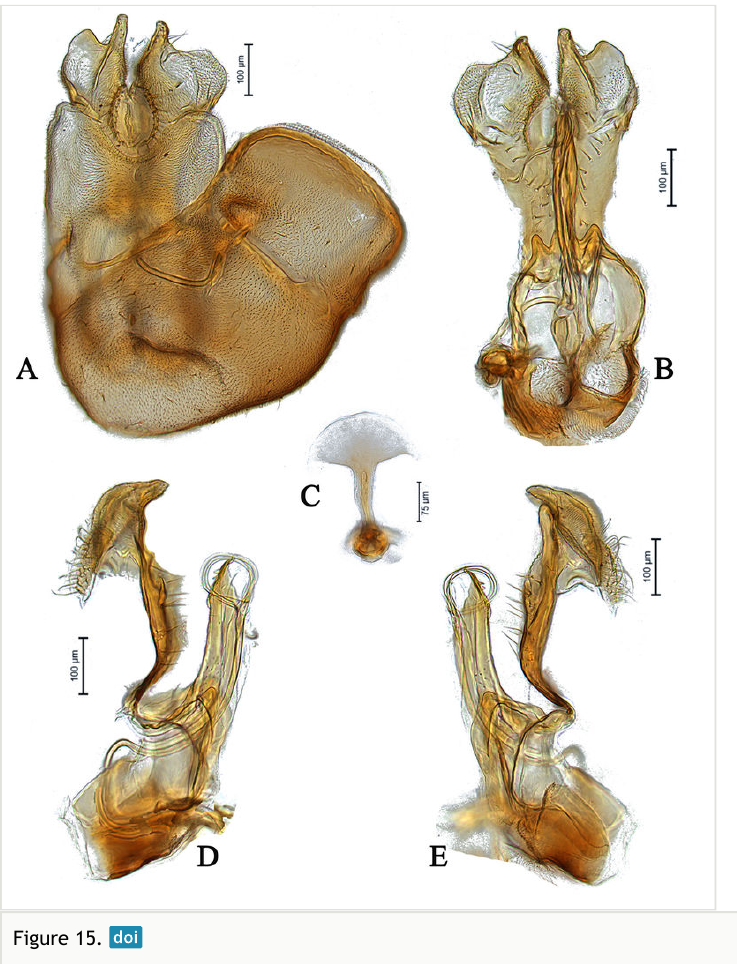
Figure 15. Male genitalia of Eudorylas gemellus (JSS50796) (A) in dorsal view; (B) in ventral view; (C) ejaculatory apodeme; (D, E) in lateral